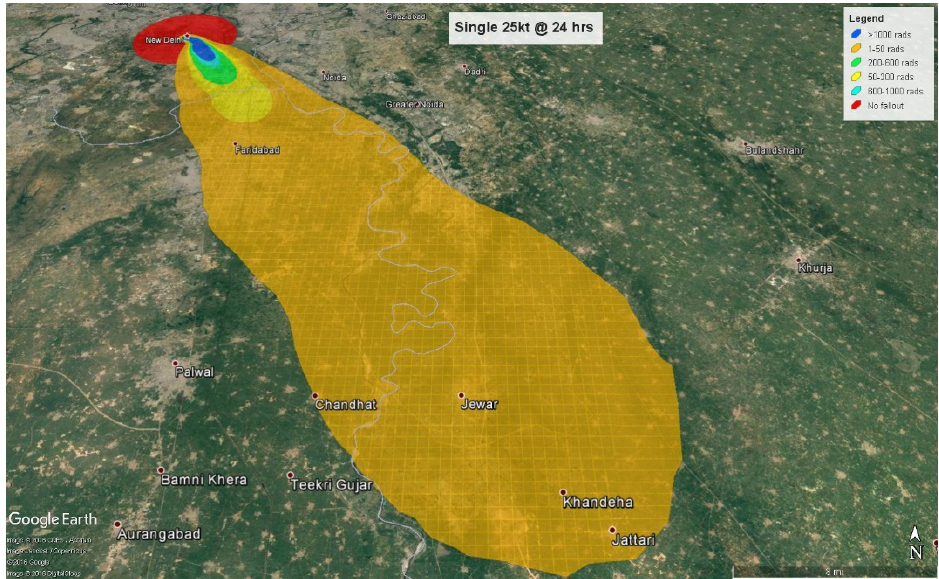
Figure 6. Fallout exposure (4 h) by triage categories.